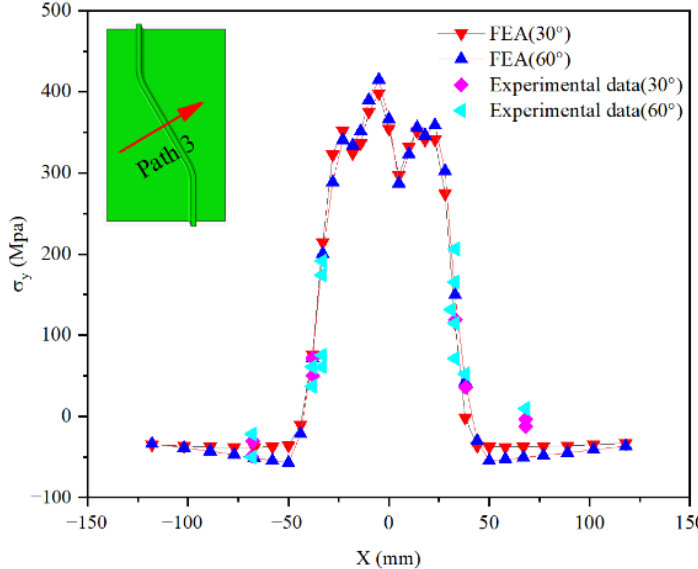
Figure 18. Comparison of CSWs experiment and simulation data.